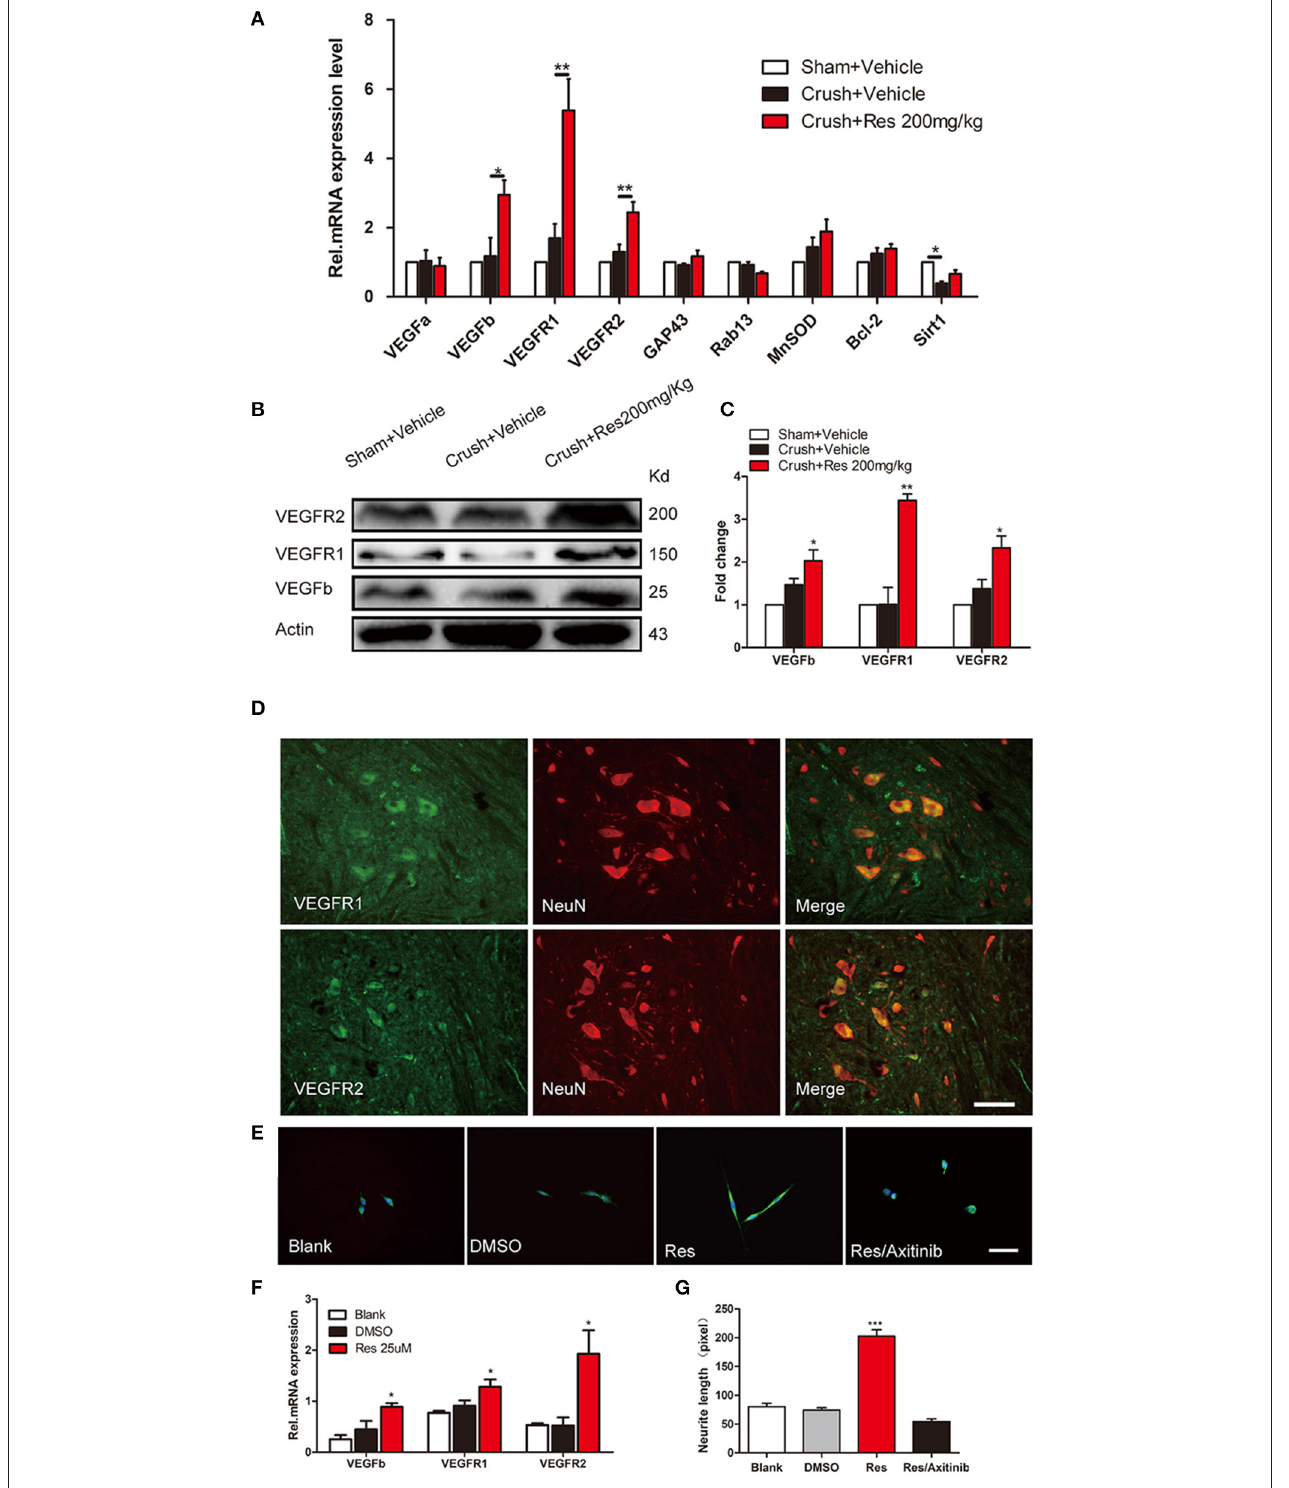
FIGURE 2 | Resveratrol (Res) up-regulated the expression of VEGFs in rat ventral spinal cord (A–D) and the inhibition of VEGFs suppressed the Res-induced axon growth in differentiated PC-12 cells (E–G) . (A) The crush injury reduced the mRNA expression of Sirt1 but did not affect the expression of other genes. Res (200 mg/Kg) increased the mRNA expression of VEGFb, VEGFR1 and VEGFR2 but did not alter the expression of other genes in rat ventral spinal cord (compared with Crush + Vehicle, * P < 0.05 , ** P < 0.01 , n = 8 for each group). (B,C) Res (200 mg/Kg) increased the protein expression of VEGFb, VEGFR1, and VEGFR2 in